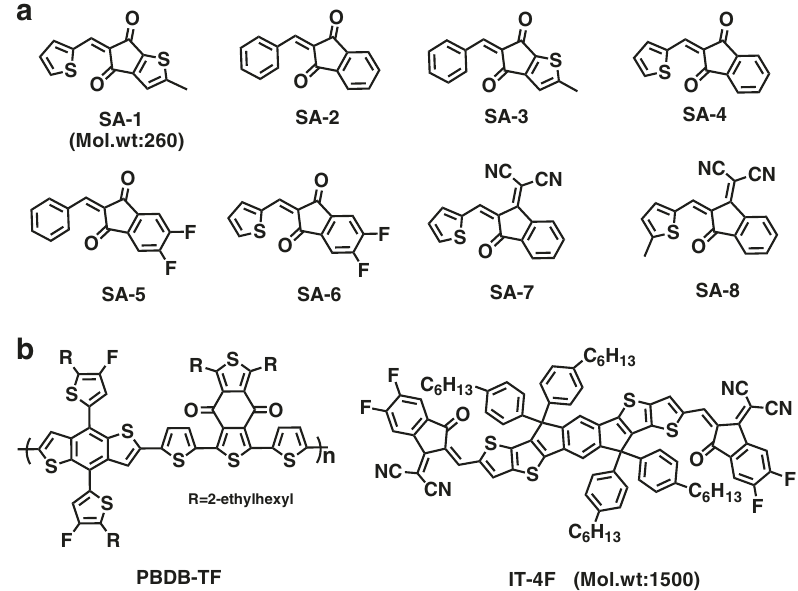
Fig. 1 Chemical structures. a Chemical structures of eight designed solid additives, SA-x. b Chemical structures of the polymer donor PBDB-TF and the acceptor